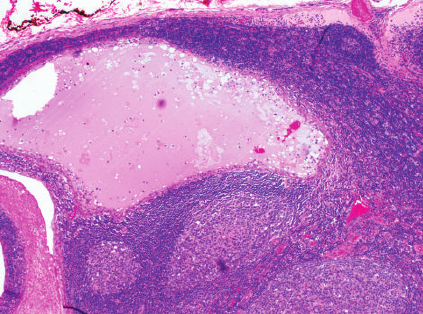
Figure 3: Section of the tumor where the lymph node capsule forms the deep margin focally. Normal lymph node architecture can be seen in this photomicrograph (40x; H&E).